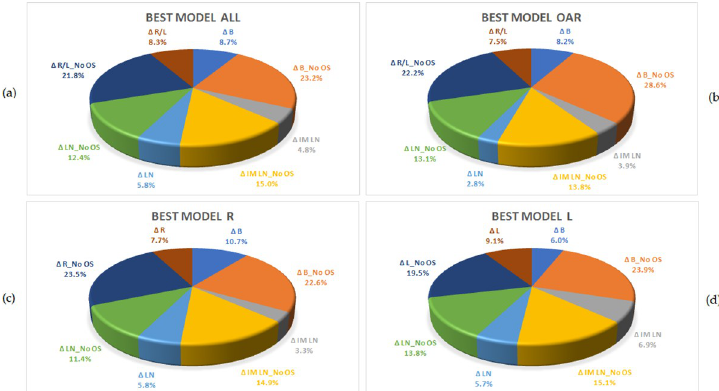
Fig 2. Pie charts show the difference Δ between reference and RP plans, or for every parameter listed in the above tables how many times the difference Δ is better for a model rather than another one. Pie chart (a) refers to the Δ of Table 1, pie chart (b) is weighted for the Δ of OARs only, pie chart (c) refers to the Δ of Table 2 for R treatments and pie chart (d) refers to the Δ of Table 2 for L treatments.